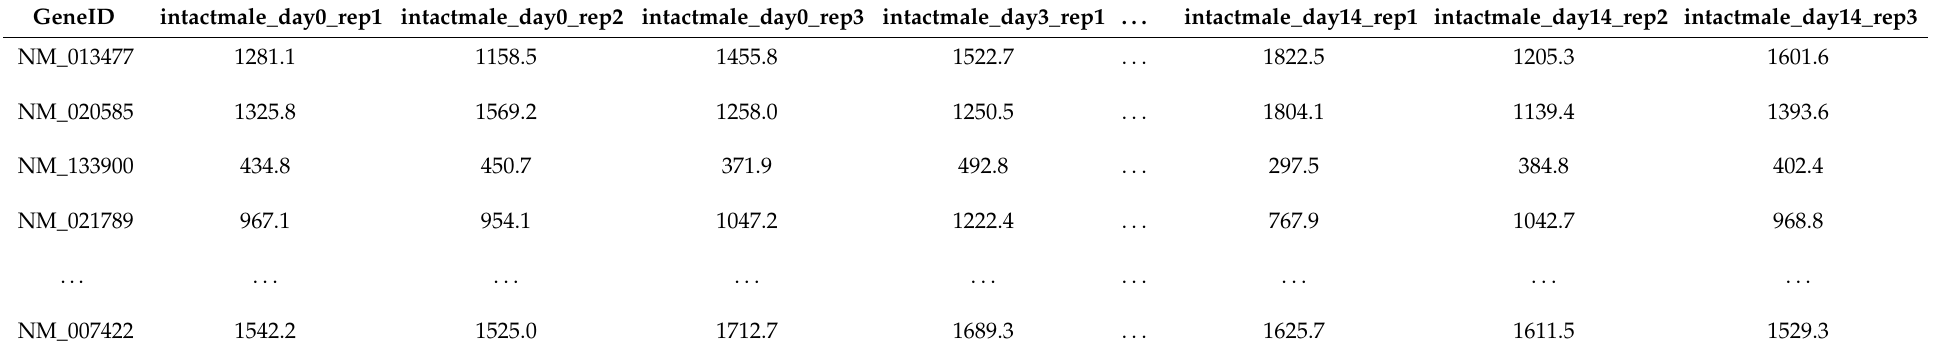
Table 1. An example time course gene expression input file of single